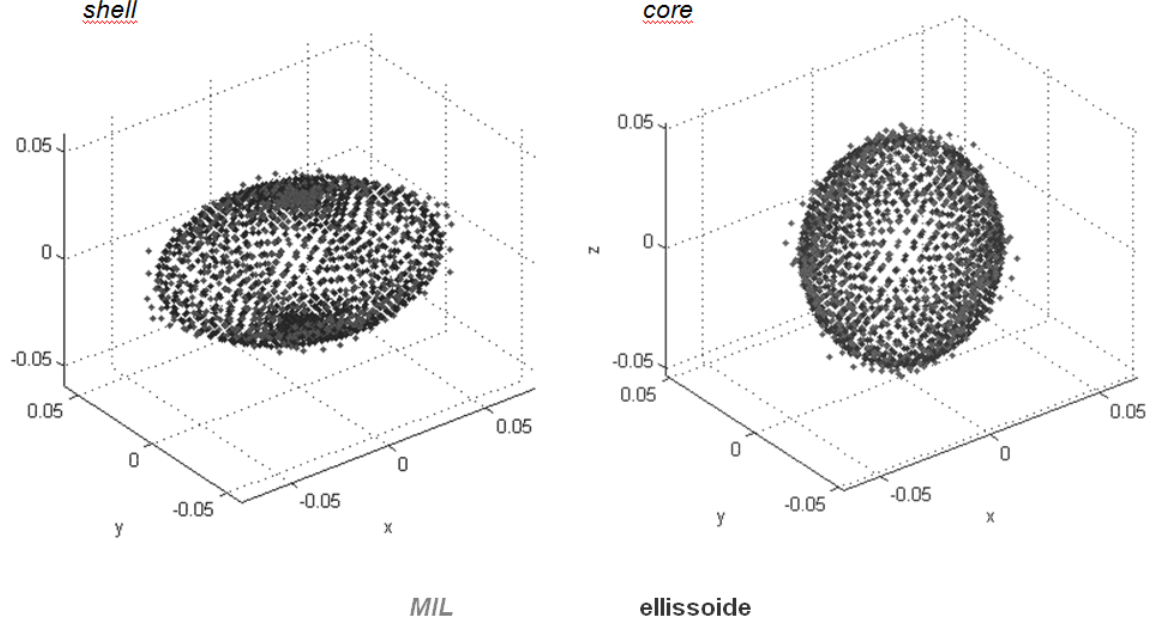
I diagrammi polari di Figg.12 e 13 rappresentano i valori